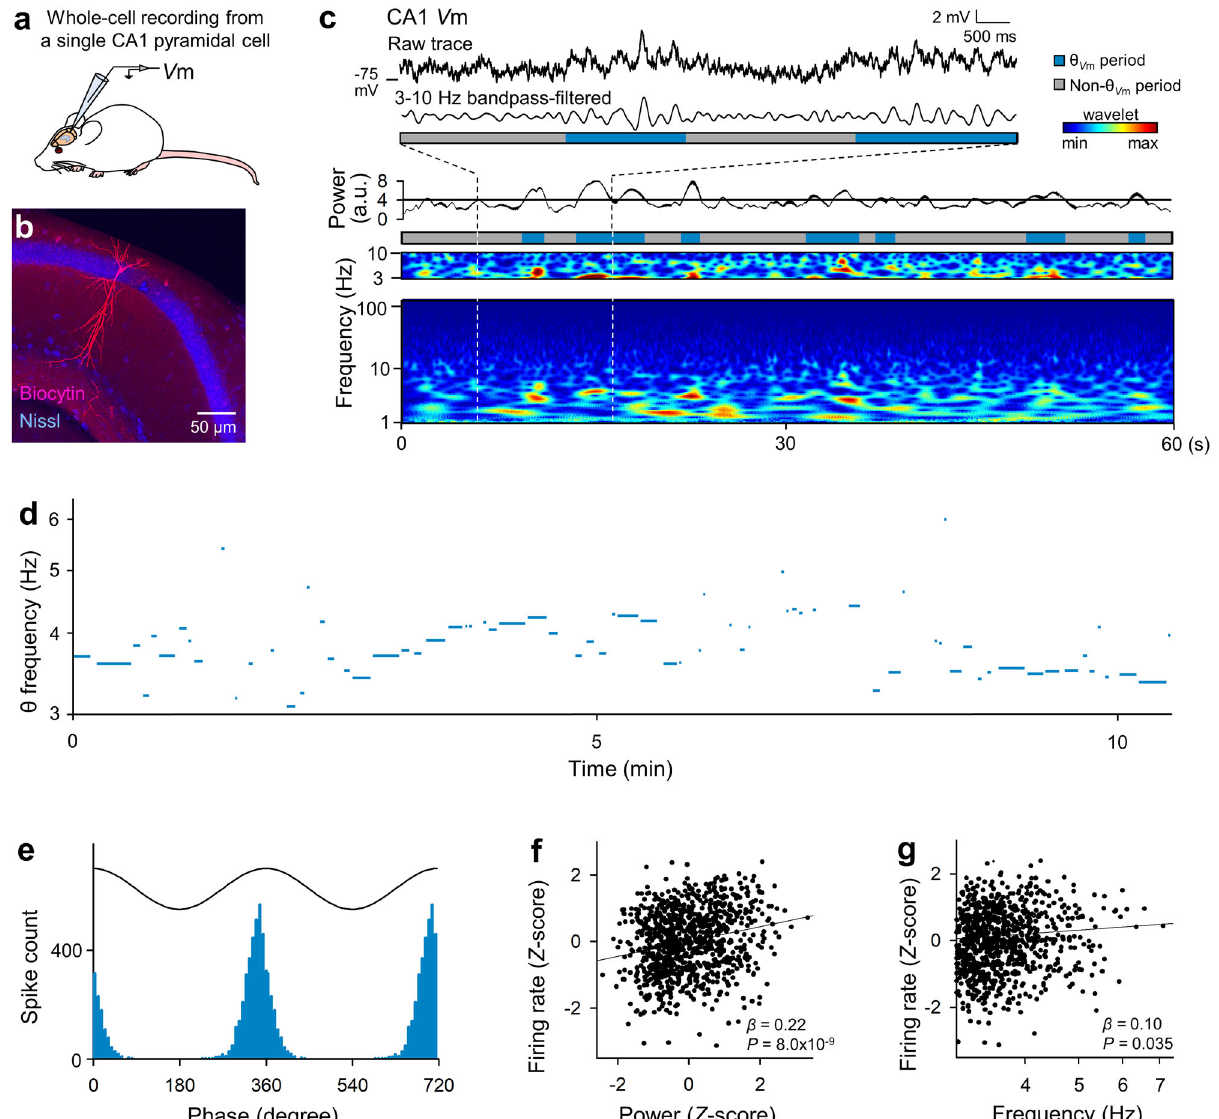
Fig. 2 Variable θ V m frequencies in a CA1 pyramidal cell. a Schematic illustration of whole-cell current-clamp recordings from a CA1 pyramidal cell. b Representative confocal image of a recorded pyramidal neuron visualized with intracellular biocytin (red) and Nissl counterstain (blue). c A raw trace of V m in a CA1 pyramidal cell (top trace) was bandpass fi ltered between 3 and 10 Hz (second row trace) and divided into θ periods (gray) based on the 3 – 10 Hz oscillation power (third row trace). The bottom plot shows the wavelet spectrogram of the V m trace. d Representative time course of the peak θ V m frequencies during individual θ V m periods, demonstrating that a single CA1 pyramidal cell exhibited θ V m at various frequencies. e Cells fi red spikes around the peaks of θ V m cycles. P < 10 − 323 , Z = 3.7 × 10 3 , Rayleigh test, n = 4655 spikes from 220 cells. f The fi ring rates increased with increases in the θ V m power. To pool data from different cells, the fi ring rates were Z -standardized on a logarithmic scale across the entire recording period of each cell. Each dot indicates the average value in a single θ V m period, and the average values of the Z -standardized parameters are superimposed on a cell-by-cell basis. The black line indicates the line of best fi t based on a generalized linear mixed model. β = 0.22, P = 8.0 × 10 − 9 , t 1032 = 5.8, t -test of the correlation coef fi cient, n = 1034 θ V m periods from all 136 cells that fi red at least one spike. g Same as f , but for the θ V m frequencies. β = 0.10, P = 0.035, t = 2.1, n = 1034 θ V m periods from 136 1032